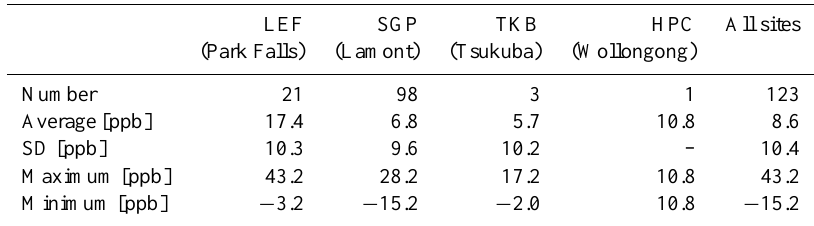
Table 7. The average, maximum, minimum, and 1 standard deviation of differences of TCCON XCH 4 (GGG2012 release) and aircraft-based XCH 4 at each observation